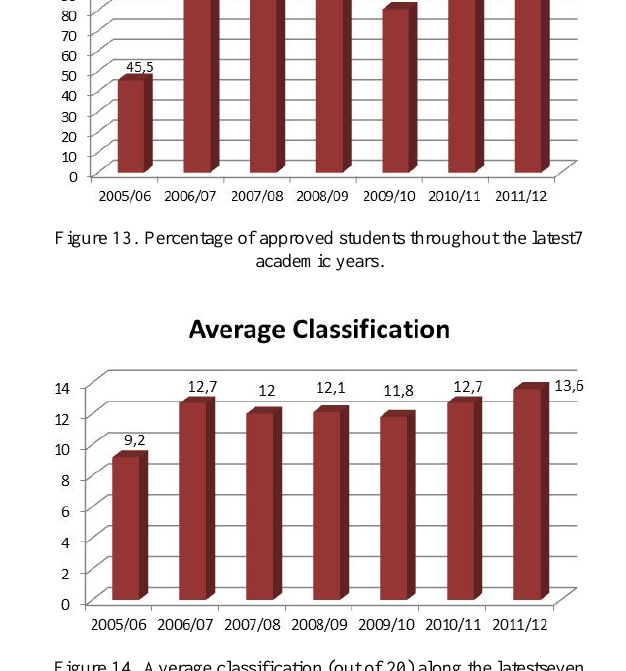
Figure 14. Average classification (out of 20) along the latestseven academic